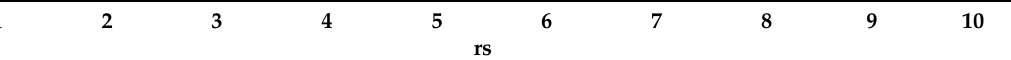
Table 2. Correlations between nursing skill mastery, test anxiety, academic self-efficacy, and facial expressions ( n =